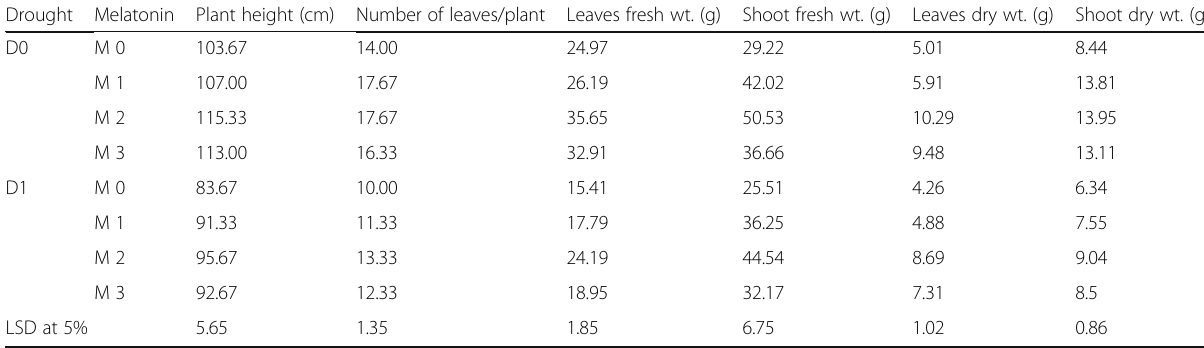
Table 2 Effect of melatonin (0, 50, 100, and 150 mM) on growth characters of M. oleifera plants subjected to drought stress (normal irrigation and skipping two irrigation times). Data are means of two seasons Drought Melatonin Plant height (cm) Number of leaves/plant Leaves fresh wt. (g) Shoot fresh wt. (g) Leaves dry wt. (g) Shoot dry wt. (g)